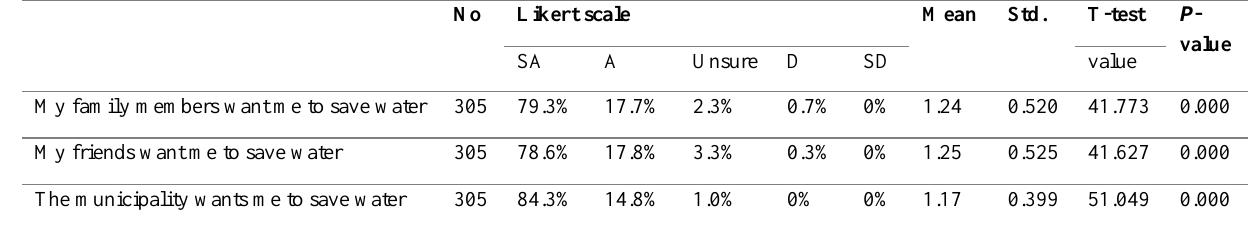
Table 5: Respondents subjective norm influence on water